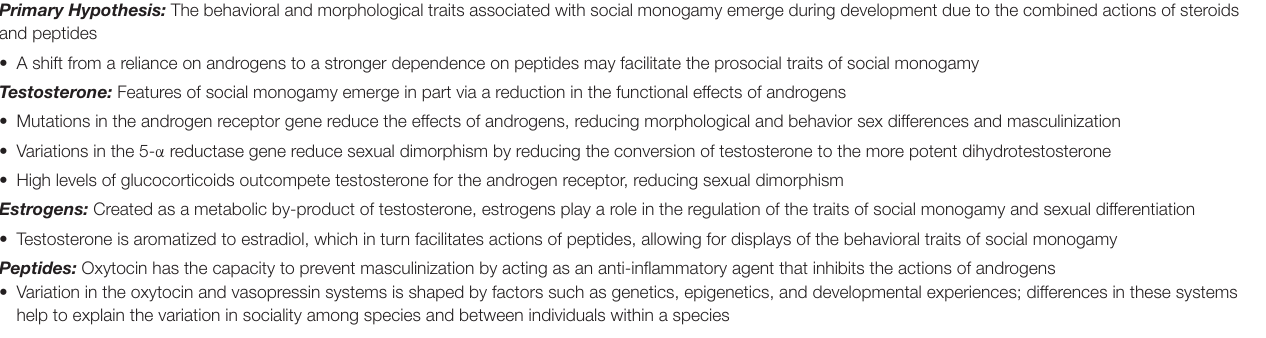
TABLE 1 | Hypotheses for the roles of steroids and peptides in the emergence of social monogamy. Primary Hypothesis: The behavioral and morphological traits associated with social monogamy emerge during development due to the combined actions of steroids and peptides